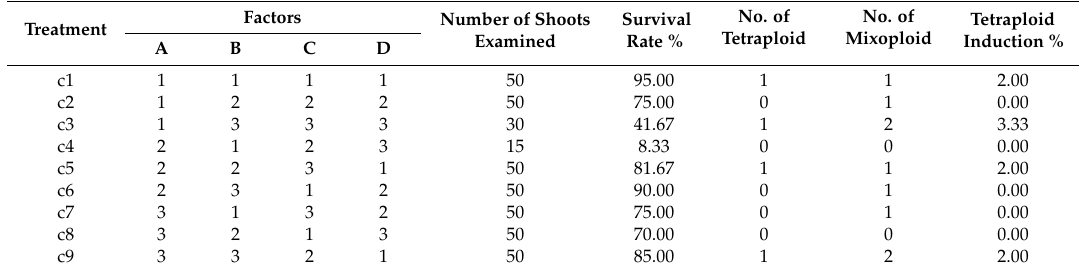
Table 2. Design of orthogonal table L 9 (3) 4 for leaves.